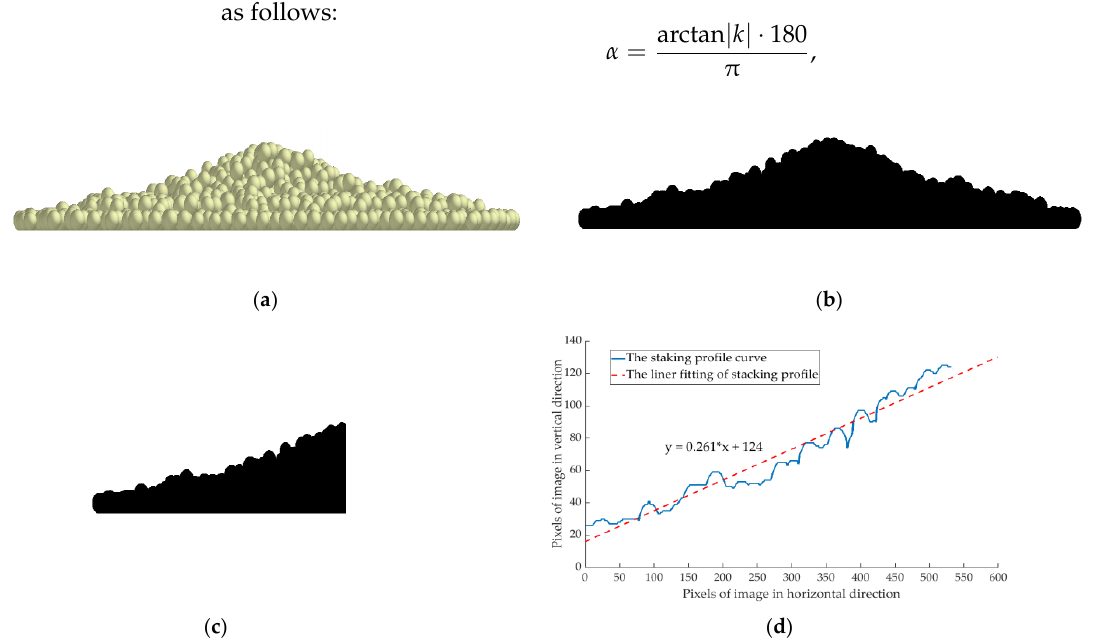
Figure 6. Contour curve extraction process. ( a ) Original stacking picture; ( b ) Binarization; ( c ) The left stacking image; ( d ) Linear fitting of bulk stacking boundary.